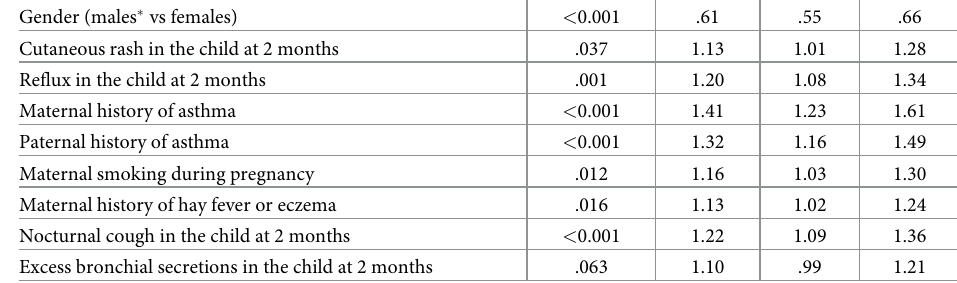
Logistic regression 2 taking non-wheezers vs persistent wheezers as the dependent